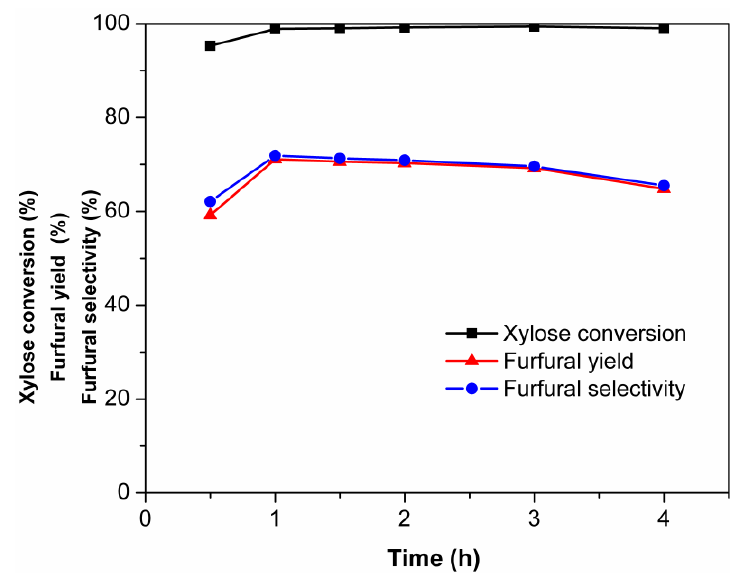
Figure 6. The xylose conversion, furfural yield, and furfural selectivity at 130 ◦ C in the EMIMBr/ SnCl 4 . Reaction conditions: 200 mg of xylose was dissolved in 1000 mg of EMIMBr; molar ratio of SnCl 4 :xylose = 1:10.